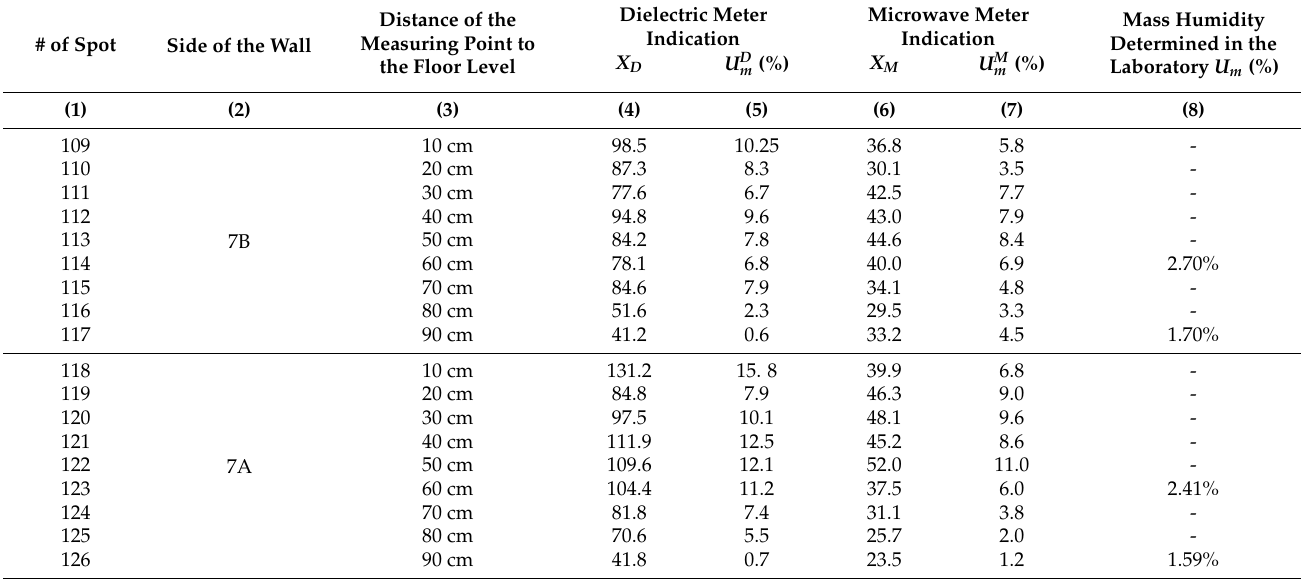
Table 2. Results of validation measurements. Percentage mass humidity obtained by: dielectric U D m , microwave U M m , and gravimetric U m methods.